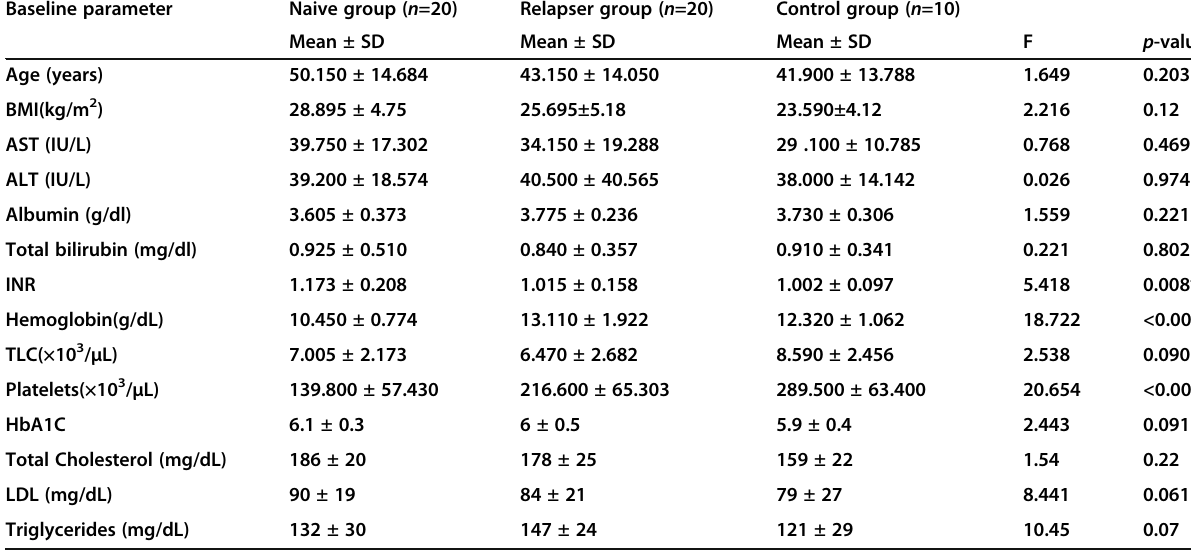
Table 1 Comparison between the 3 groups regarding demographic and laboratory findings Baseline parameter